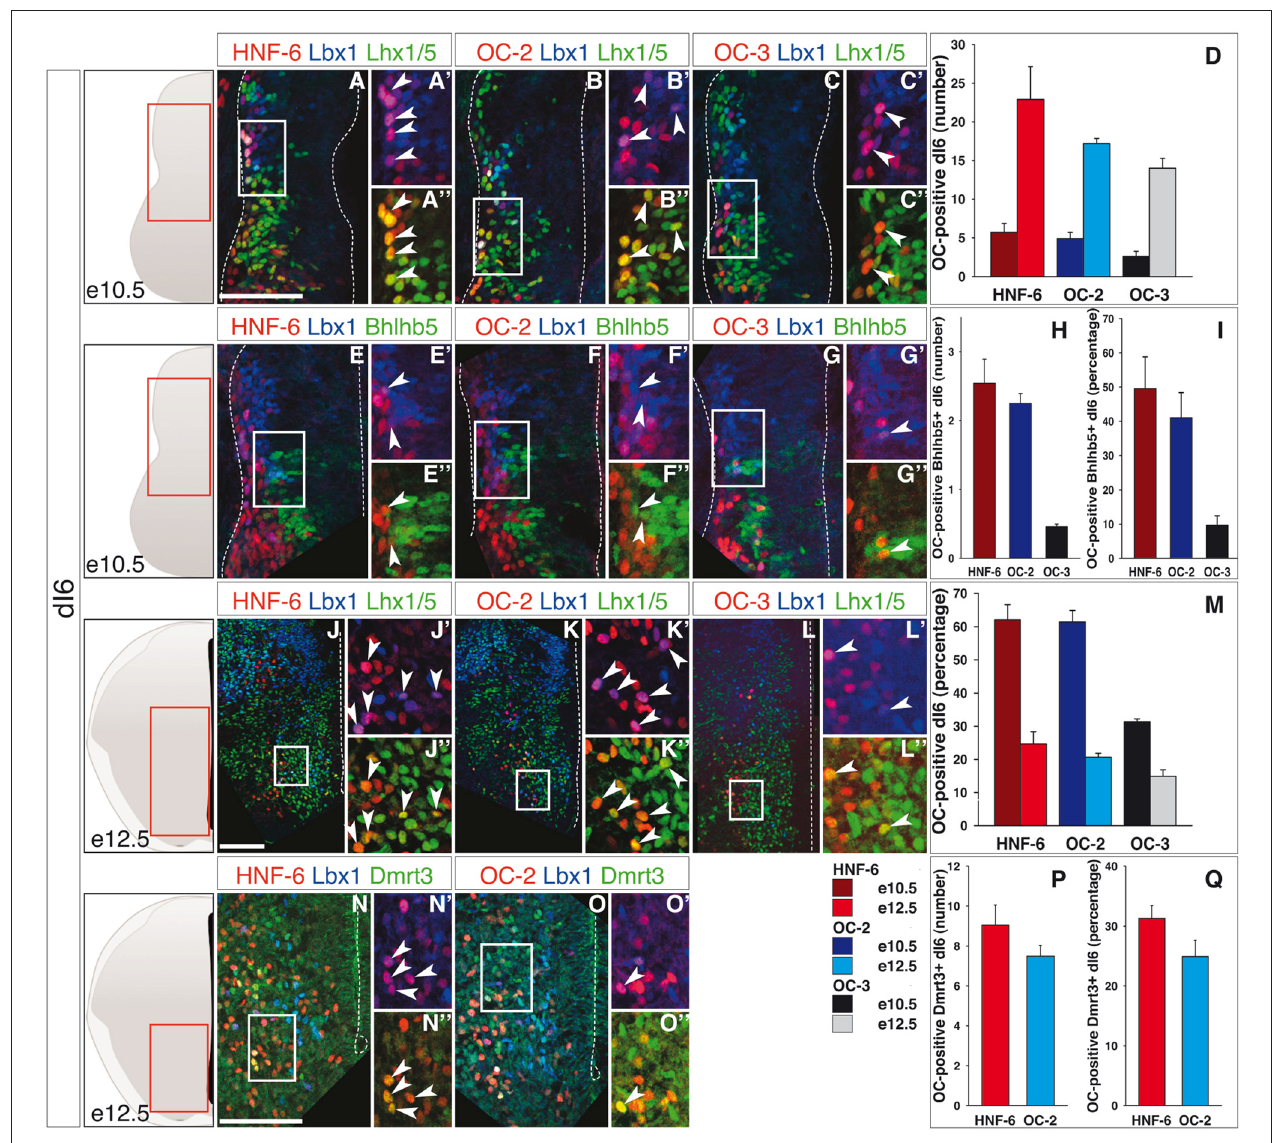
FIGURE 3 | OC factors are differentially and dynamically distributed in dI6 population and sub-populations during development. (A–I) Immunodetection of HNF-6, OC-2 or OC-3 (red) in double-labeled Lbx1 + (blue)-Lhx1/5 + (green, A–C ) dI6 population or in Bhlhb5 + (green, E–G ) dI6 subpopulation on transverse sections of thoracic spinal cord at e10.5. HNF-6 (A,E) and OC-2 (B,F) are present in a majority of Lbx1 + Lhx1/5 + dI6 neurons and in a significant number of Bhlhb5 + newly-born dI6 while OC-3 (C–G) is limited to a smaller number of cells. The number (D–H) and percentage (I–M) of OC-positive dI6 neurons per hemisection were quantified accordingly. (J–Q) Immunodetection of HNF-6, OC-2 or OC-3 (red) in double-labeled Lbx1 + (blue)-Lhx1/5 + (green, J–L ) dI6 neurons or in Dmrt3 + (green, N,O ) dI6 subpopulation on transverse sections of thoracic spinal cord at e12.5. HNF-6 (J,N) and OC-2 (K,O) are mainly detected in dI6 neurons located in ventral spinal cord. OC-3 (L) is also detected in Lbx1 + Lhx1/5 + dI6 neurons. Its presence in Dmrt3 + dI6 could not be evaluated due to incompatibility between antibody species. (D,M) Quantifications of ventrally located dI6 neurons containing HNF-6, OC-2 or OC-3 at e12.5 show an important increase in the number